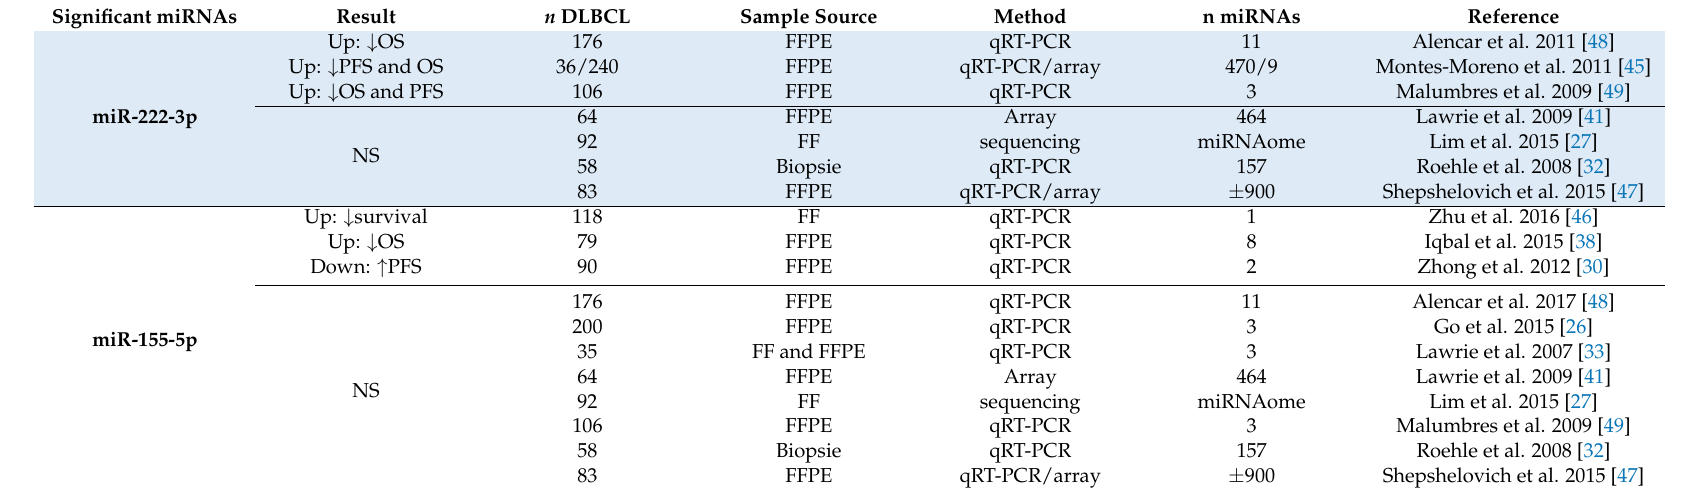
Table 3. miRNAs significantly associated with DLBCL prognosis in more than two studies.